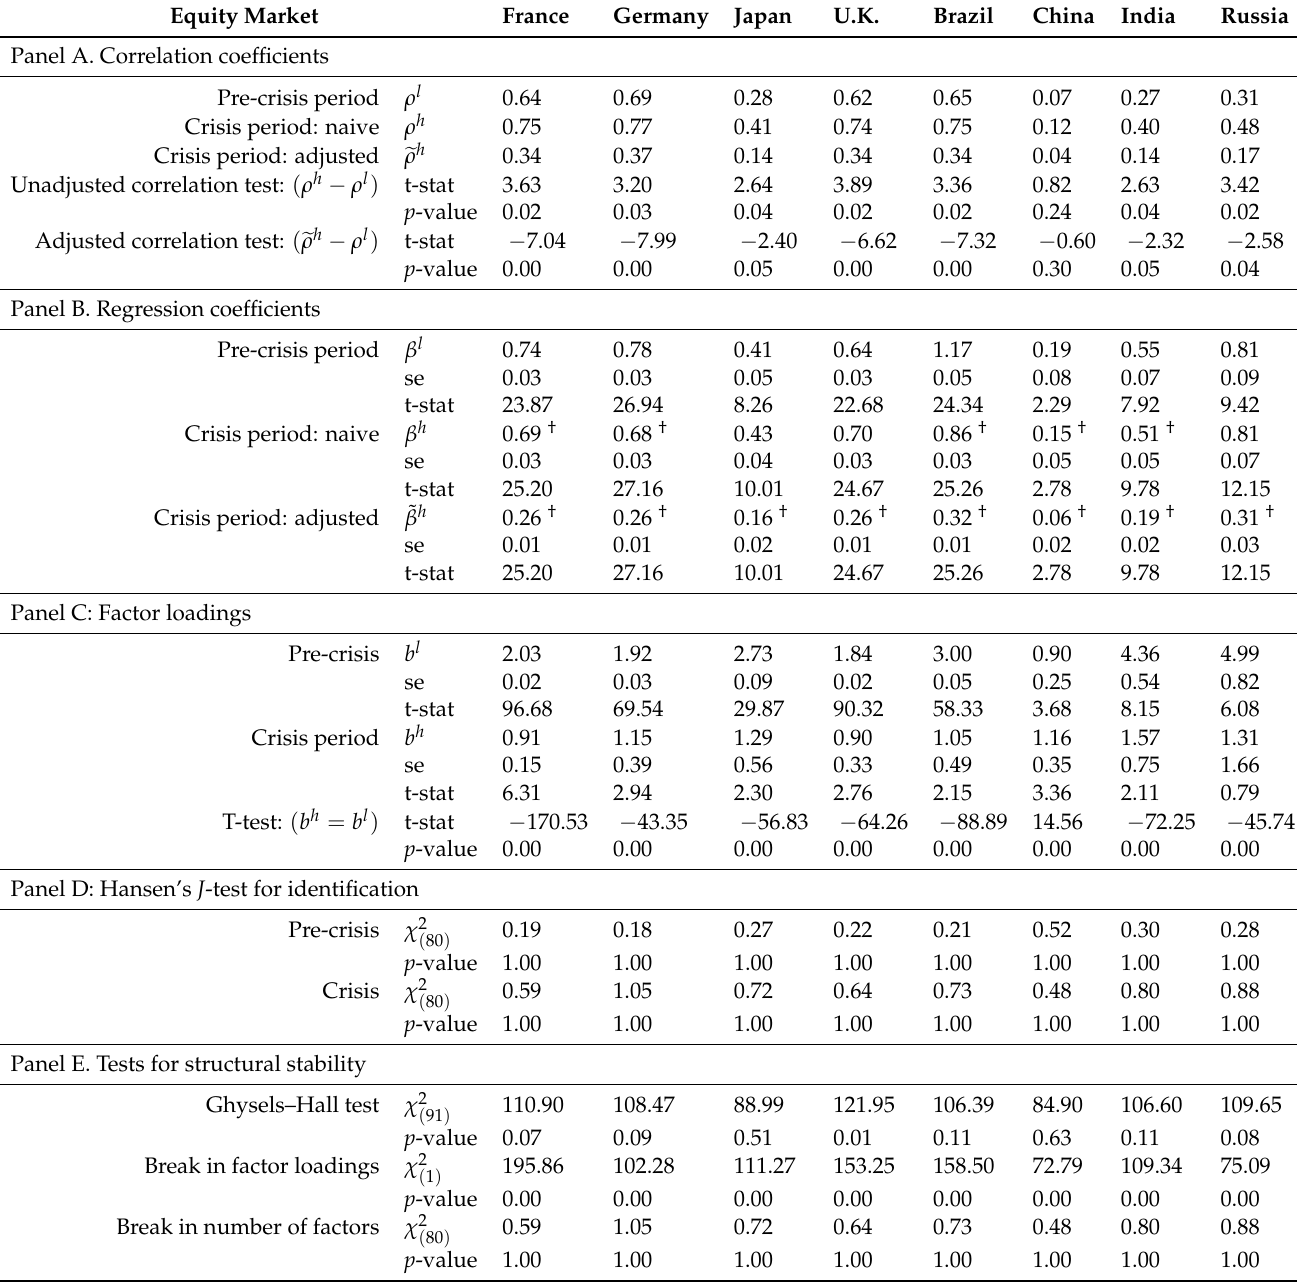
Table 3. Tests of contagion in the aggregate equity market